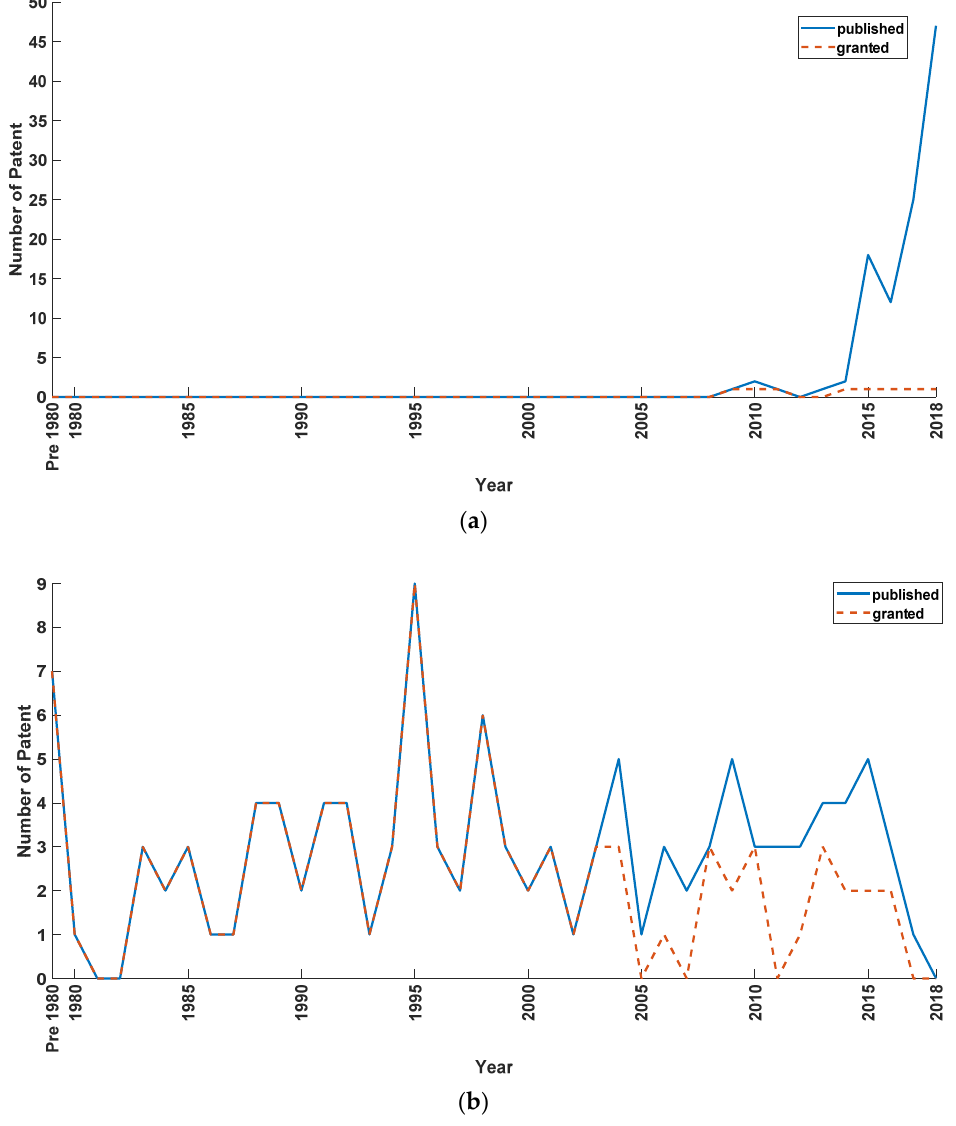
Figure 4. ( a ) Number of published and granted patents by China, and ( b ) Number of published and granted patents by the United States of America, according to publication year. granted patents by the United States of America, according to publication